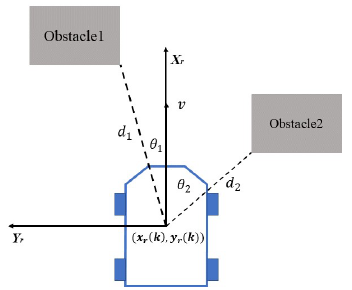
Figure 7. The situation with